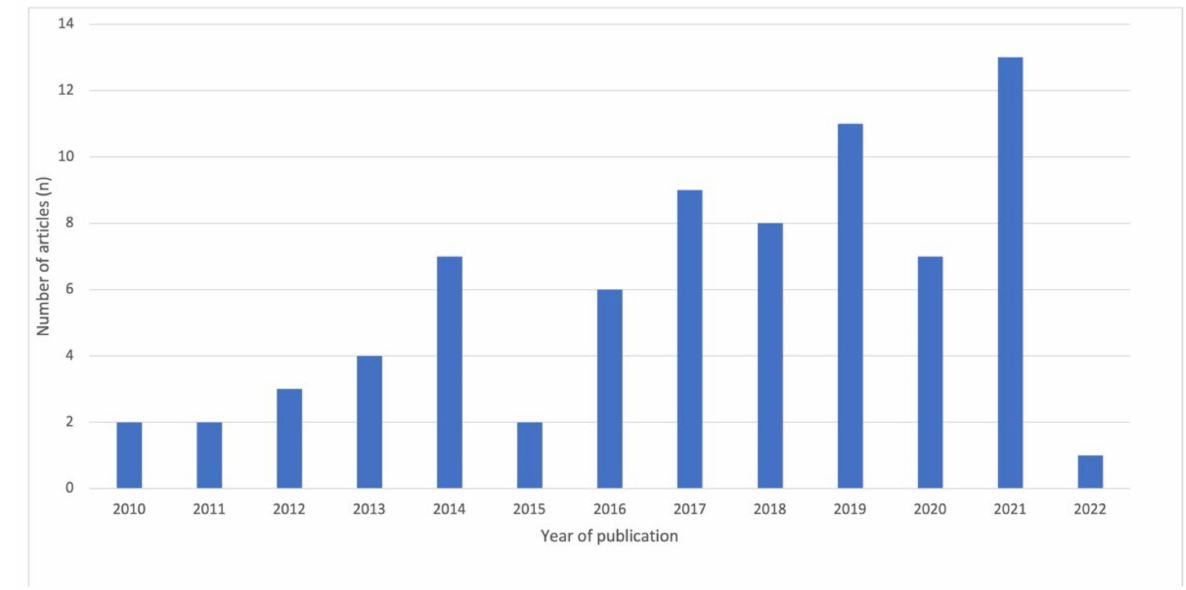
Figure 2. Year of publication